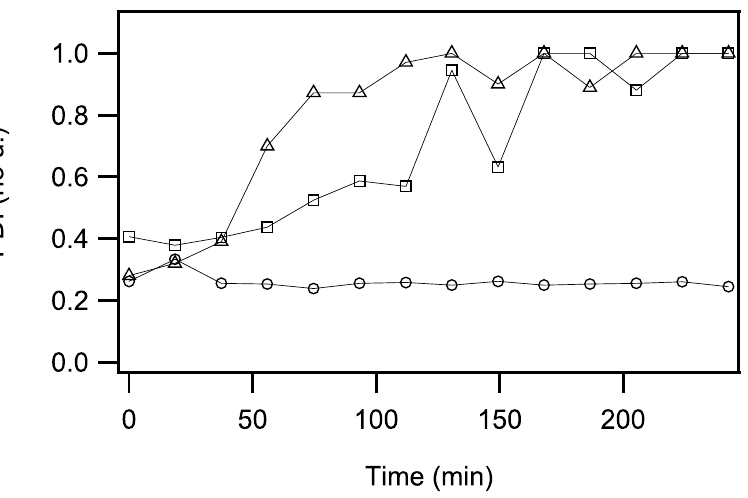
Figure 5. Time-dependent changes of polydispersity: the polydispersity index (PDI) is as a function of time for SUVs in the presence of htt17-Q9 (circles), htt17-Q12 (squares), or htt17-Q17 (triangles) in 10 mM Tris-HCl, pH7. Measurements were performed by dynamic light scattering in the absence of mechanical stirring. The same concentrations of lipids and peptides were used as in the CD experiments presented in Figures 1 and 2. Data points were recorded every 19 – 20 min.